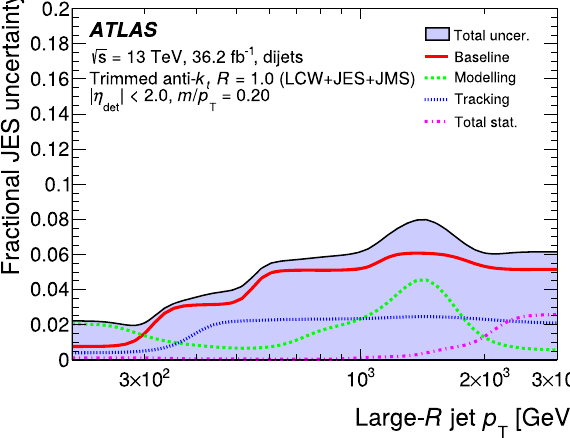
Fig. 15 The total uncertainty in the relative jet energy scale in data and simulations associated with the R trk method is plotted as a function of jet transverse momentum p T . The large- R jet p T is corrected using the simulation calibration, η -intercalibration, and a combination of in situ direct balance techniques. The contributions from several sources are indicated. The baseline uncertainty represents the deviation of the dou- ble ratio from unity for the baseline simulations. The lines shown are obtained by smoothing a binned representation of these uncertainties using a sliding Gaussian